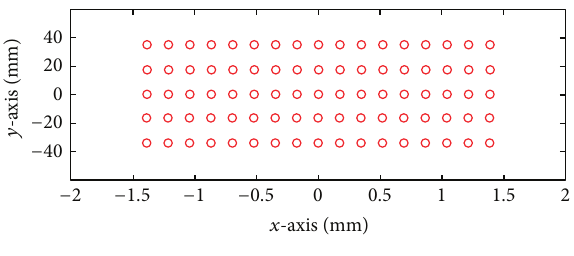
Figure 4: Spatial sources distribution.